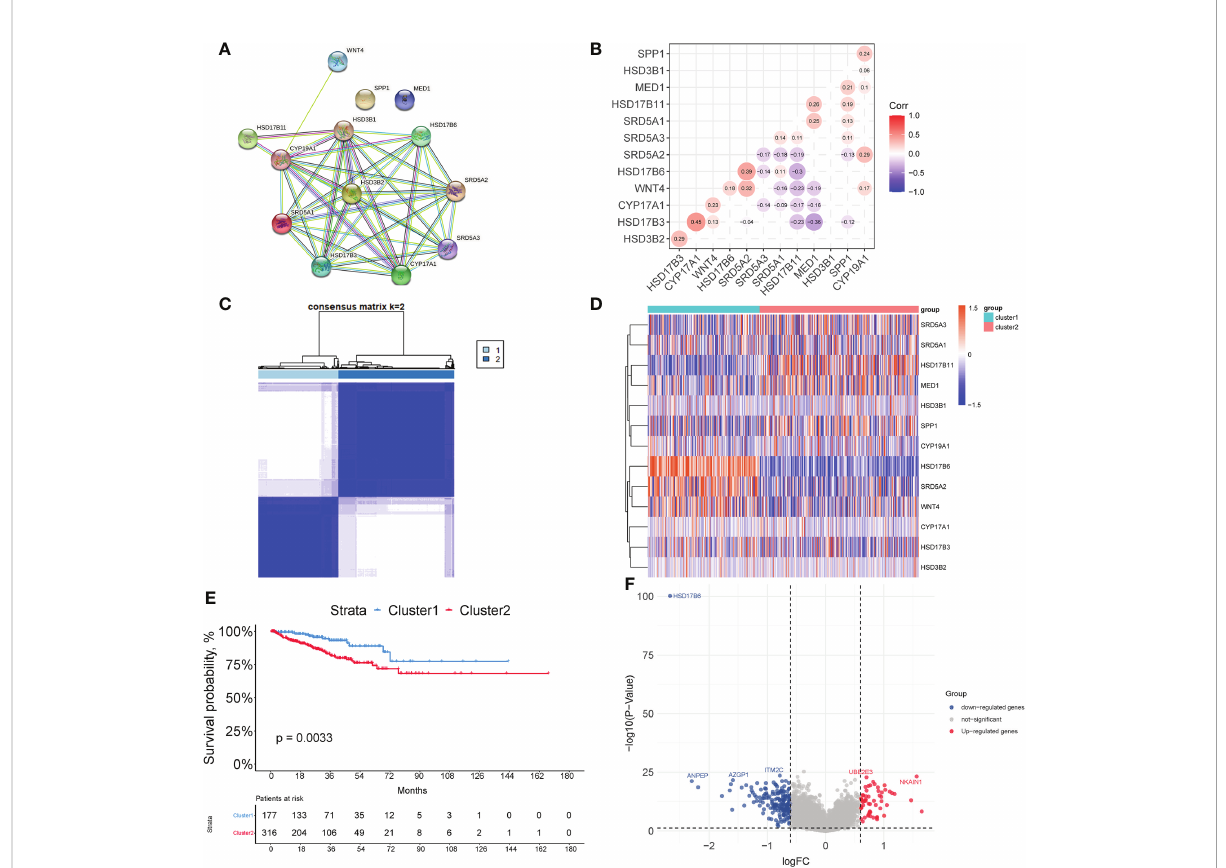
FIGURE 1 Consensus clustering based on androgen biosynthetic and catabolic pathways. (A) The PPI network of ABCGs constructed in the STRING database. (B) Gene expression correlation of ABCGs in TCGA cohort. (C) Consensus Clustering matrix (k =2). (D) Heatmap of ABCGs in two clusters. (E) Kaplan-Meier curves of RFS. (F) The different expression genes (DEGs) between cluster1 and cluster